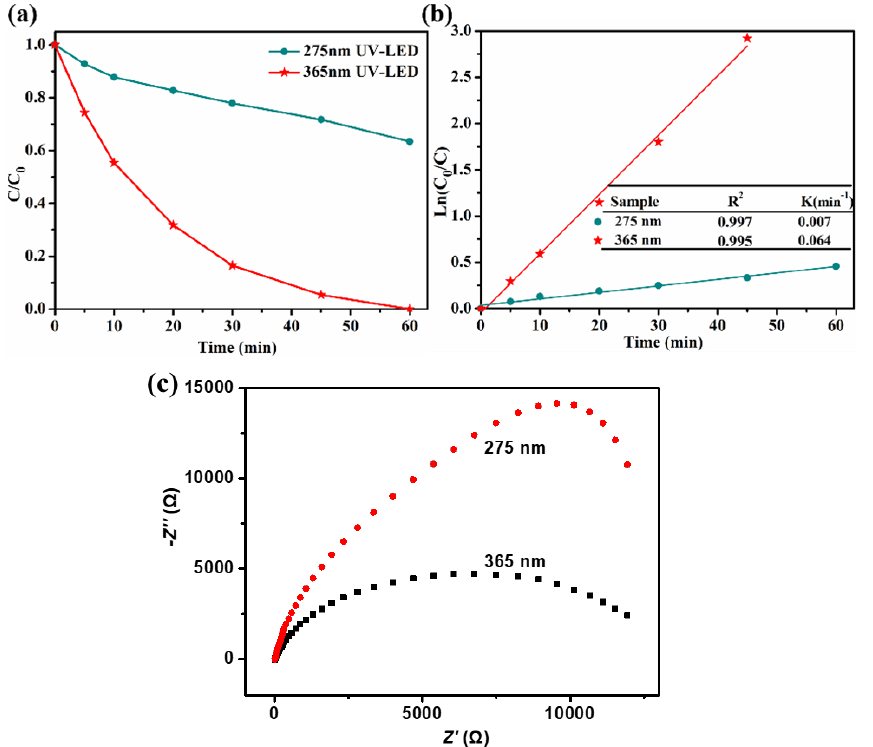
Figure 4. ( a ) Effect of varying UV-LED wavelengths on ATL degradation: C (ATL) 0 = 18.77µM; ( b ) Pseudo- first-order model of ATL degradation. ( c ) the EIS of mixed phase under UV-LED at a wavelength of 365 and 275 nm. C mixed phase) = 2.0 g/L; I 0 = 774 µW/cm 2 ; pH: 7.6; temperature: 20 °C.